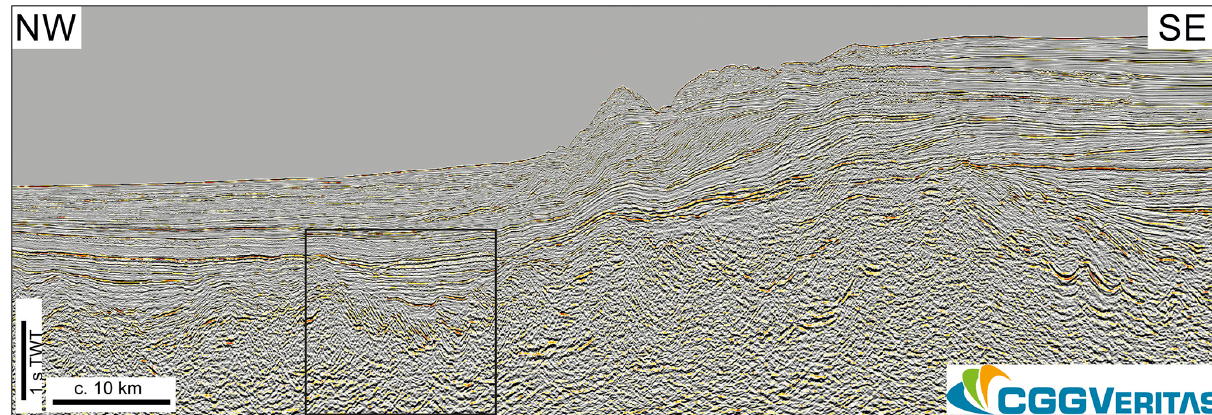
Figure 1. Regional seismic image from the Browse Basin (NW Australia). The black box marks the area of the section used in the interpretation experiment. Note that the vertical exaggeration of the image is high (1 : 8). The full section, with approxi- mately no vertical exaggeration (i.e. 1 : 1 display), can be downloaded from the VSA website (https://www.seismicatlas.org/entity?id= b39b298b-20fa-4944-a9b8-66b72d3a9ca8, last access: 30 September